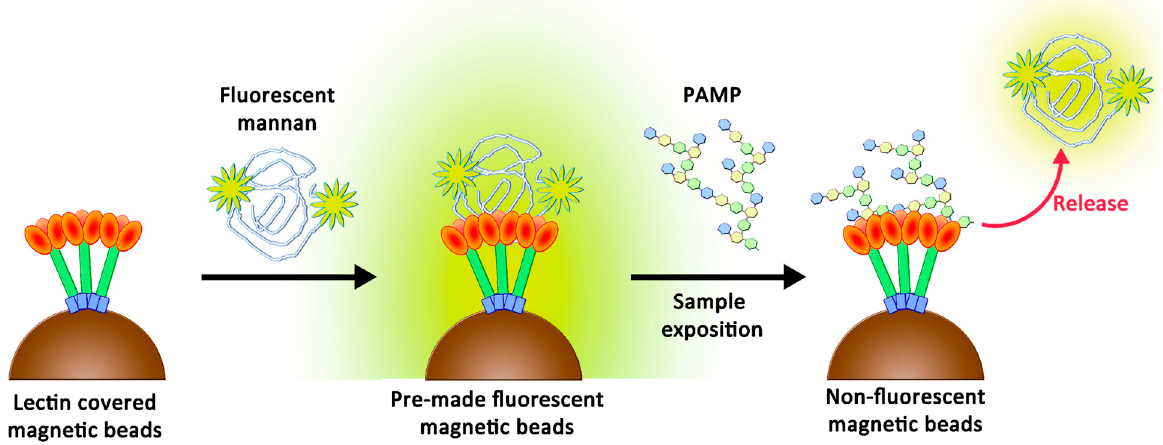
Figure 2. Two-stage competition between PAMPs and fluorescent mannan formerly caught by lectins.